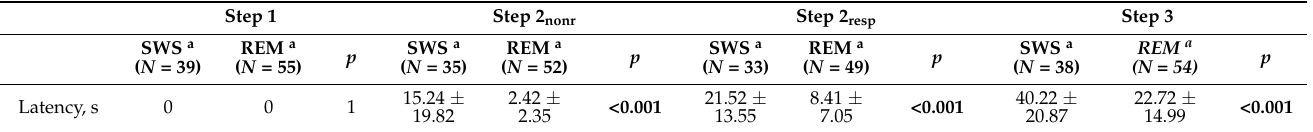
Table 1. Between sessions comparison of latency of each Step of